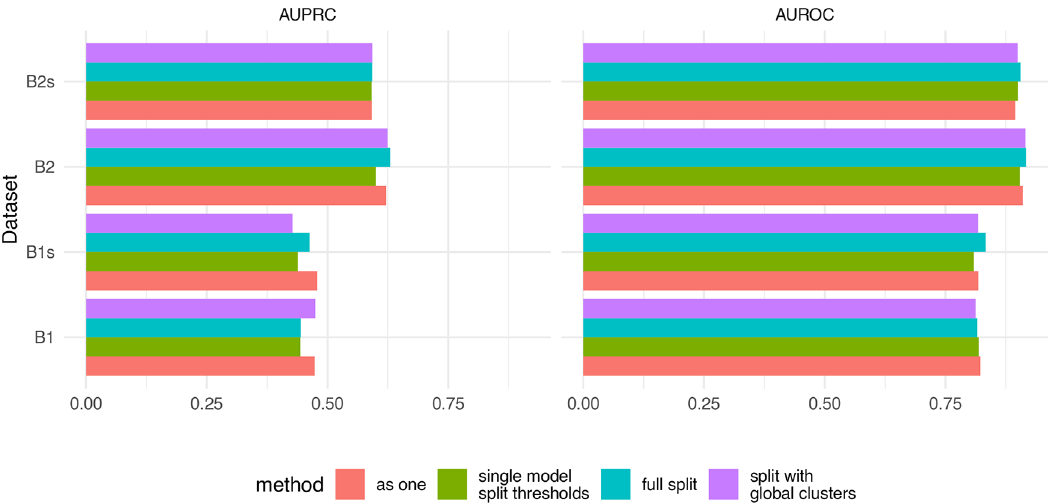
Figure 6. Comparison of four multi-sample strategies. B1 and B2 the two batches from dataset GSE96583, and contain 3 and 2 captures, respectively. The datasets with the suffix ‘ s ’ are versions downsampled to 30%. Using doublet detection on each capture separately (full split) was generally comparable to treating the captures as one (and adjusting the doublet